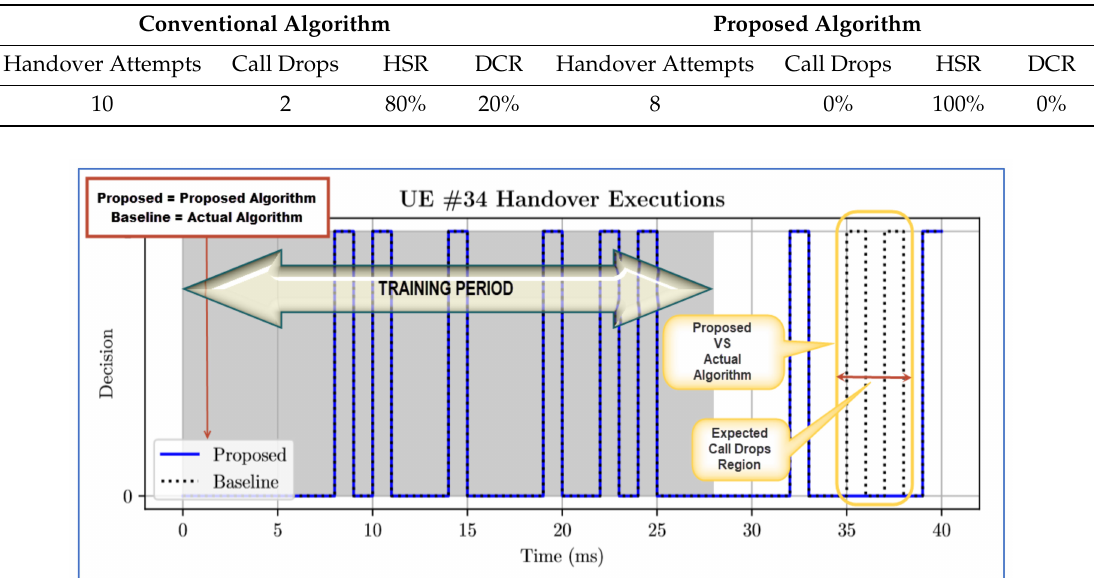
Table 5. UE#35 conventional vs. proposed algorithm handover data. HSR—handover success rate; DCR—drop call ratio.